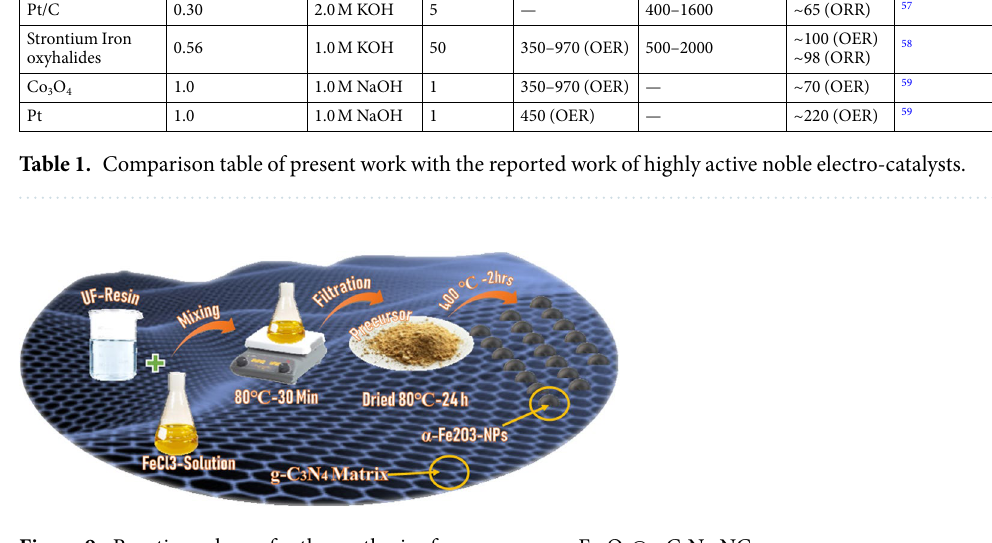
Figure 9. Reaction scheme for the synthesis of mesoporous α -Fe 2 O 3 @g-C 3 N 4